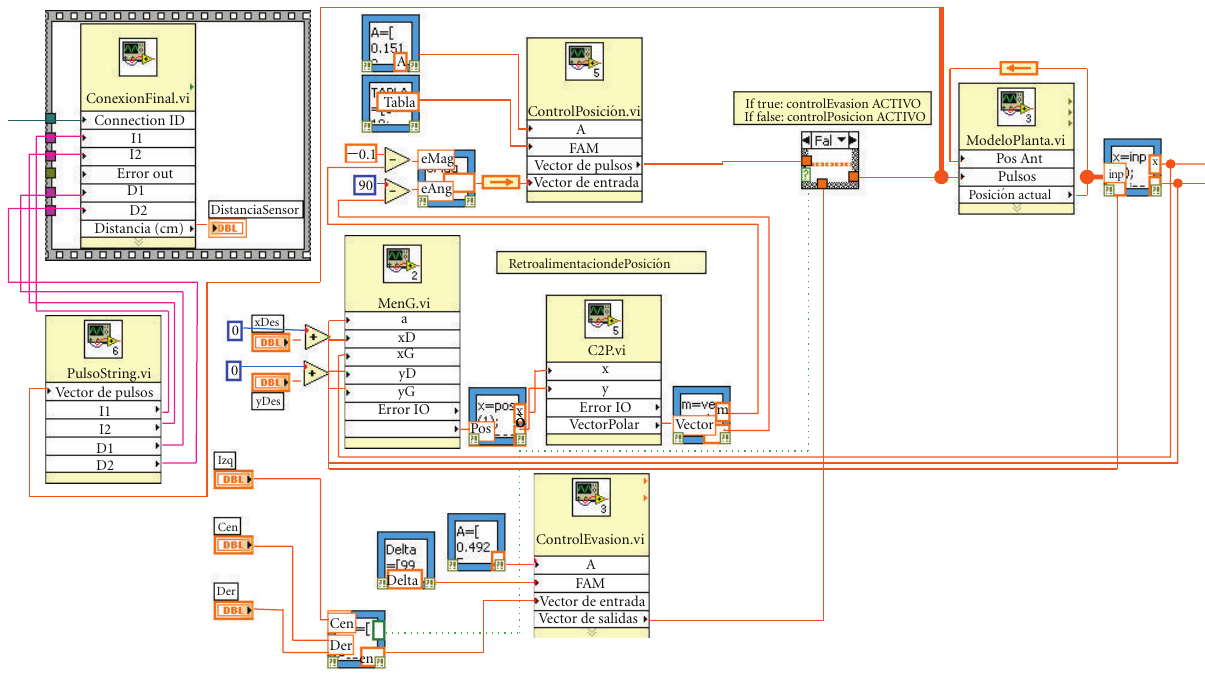
Figure 8: Controller developed in LabVIEW (Block diagram).